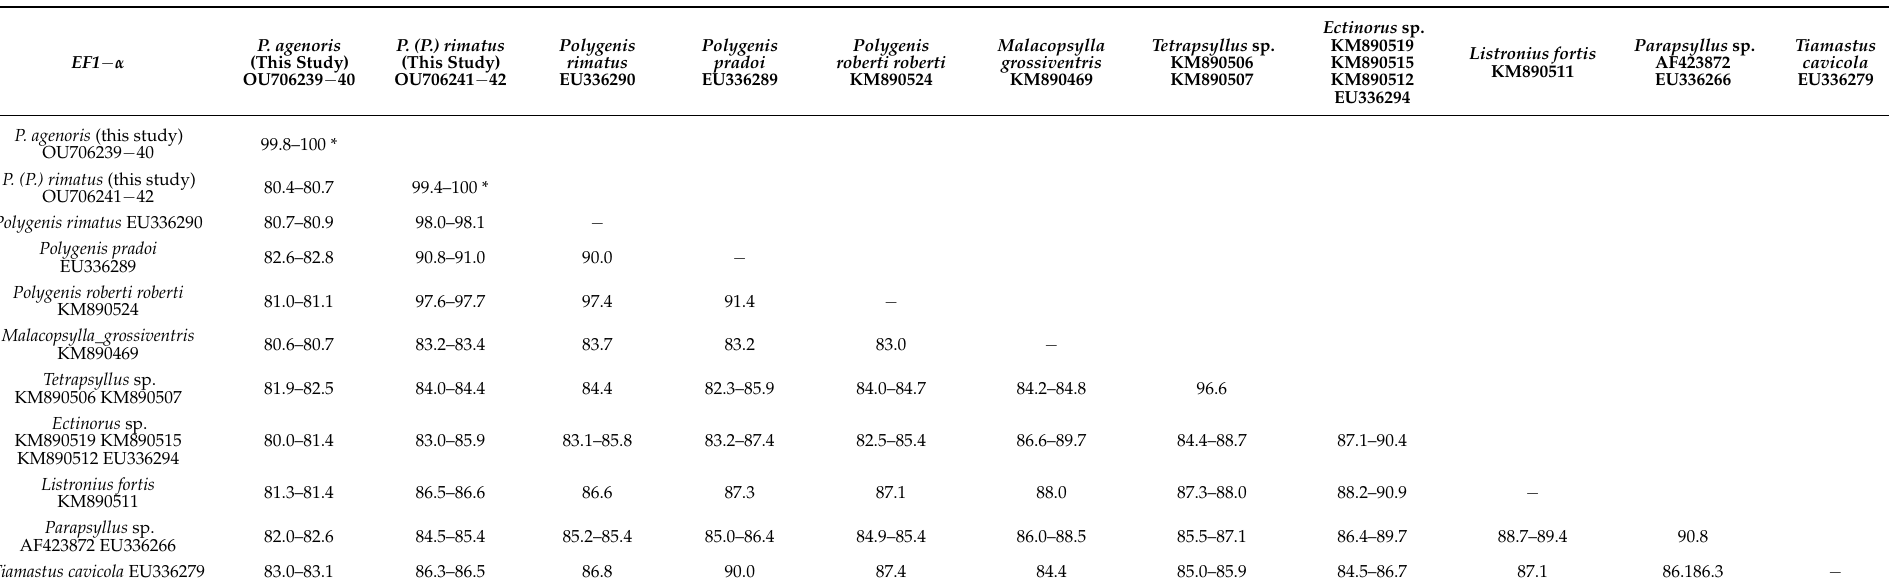
Table 2. Intraspecific (*) and interspecific similarities observed among all partial EF1 − α gene sequences of nuclear DNA of P. agenoris and P. (P.) rimatus (obtained in this study) and different species and genera belonging to Rhopalopsyllidae and Malacopsyllidae families retrieved from GenBank database. Values are given in